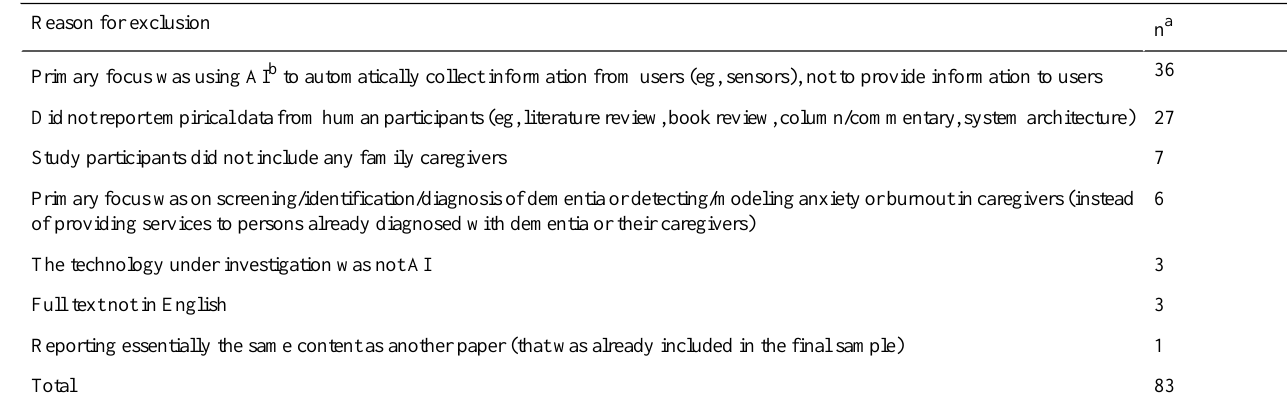
Table 1. Summary of the reasons for excluded papers.